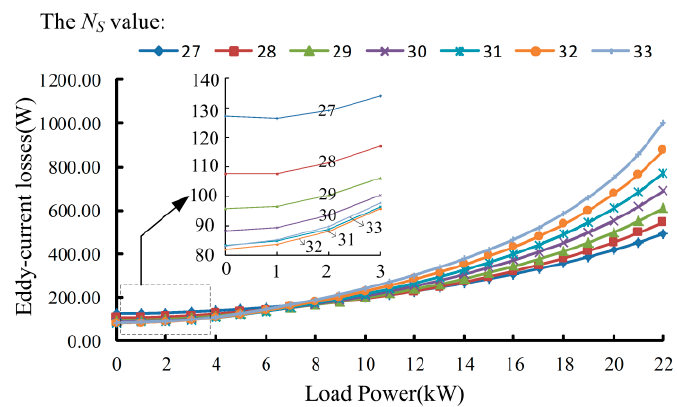
Figure 14. Eddy current loss with different N S values versus load power.